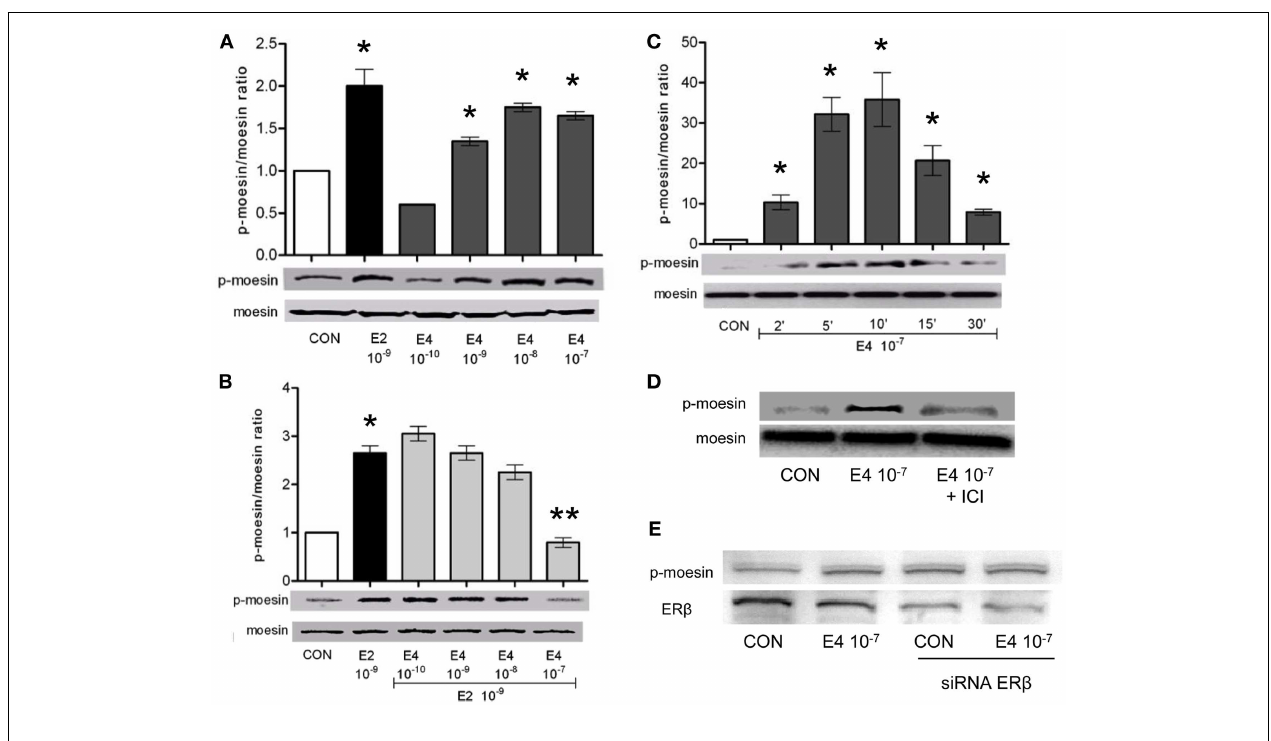
FIGURE 4 | Estetrol modulates the activation of the actin-binding protein, moesin .T47-D ER + breast cancer cells were treated for 10min with different amounts of E4, E2, or the combination (A,B) . Other cells were treated with E4 (10 − 7 M) for different times (C) . Lastly,T47-D cells were treated with E4 (10 − 7 M) in the presence or absence of the pure ER antagonist ICI 182,780 (D) or of siRNAs toward